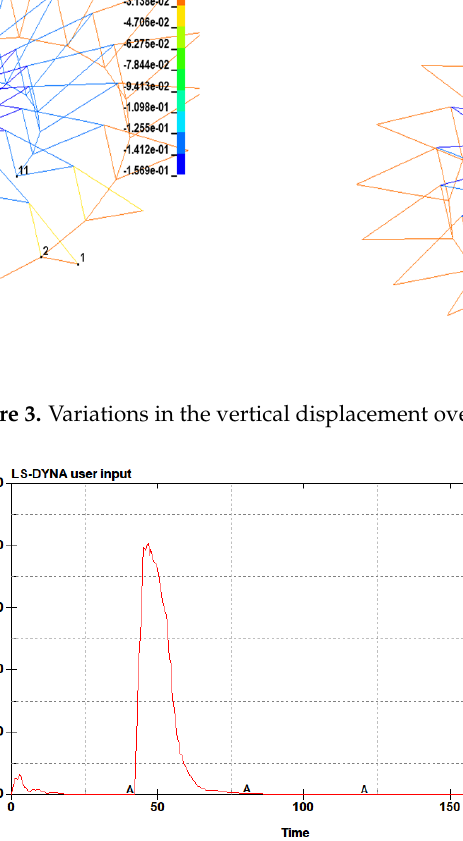
Figure 4. Variations in the kinetic energy with time.